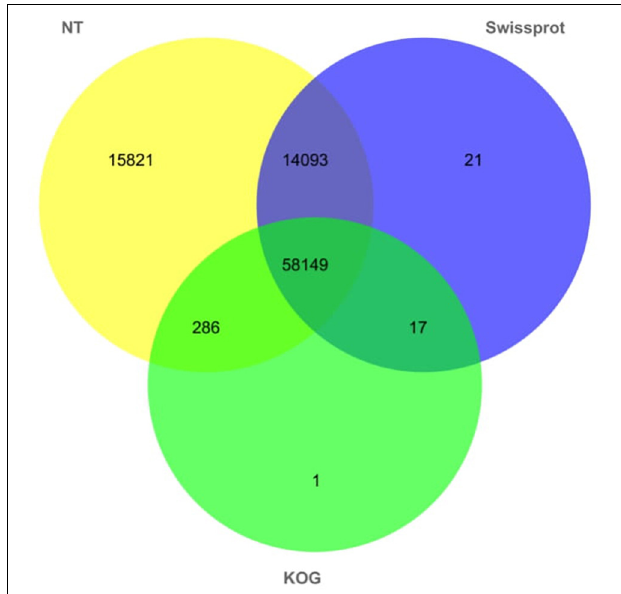
TABLE 2 | The number of alternative splicing (AS) event. FIGURE 6 | Number distribution of functional notes of full-length